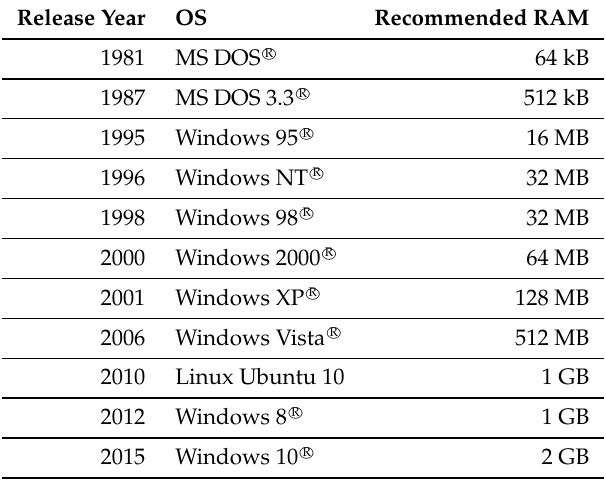
Table 2. Recommended memory for personal